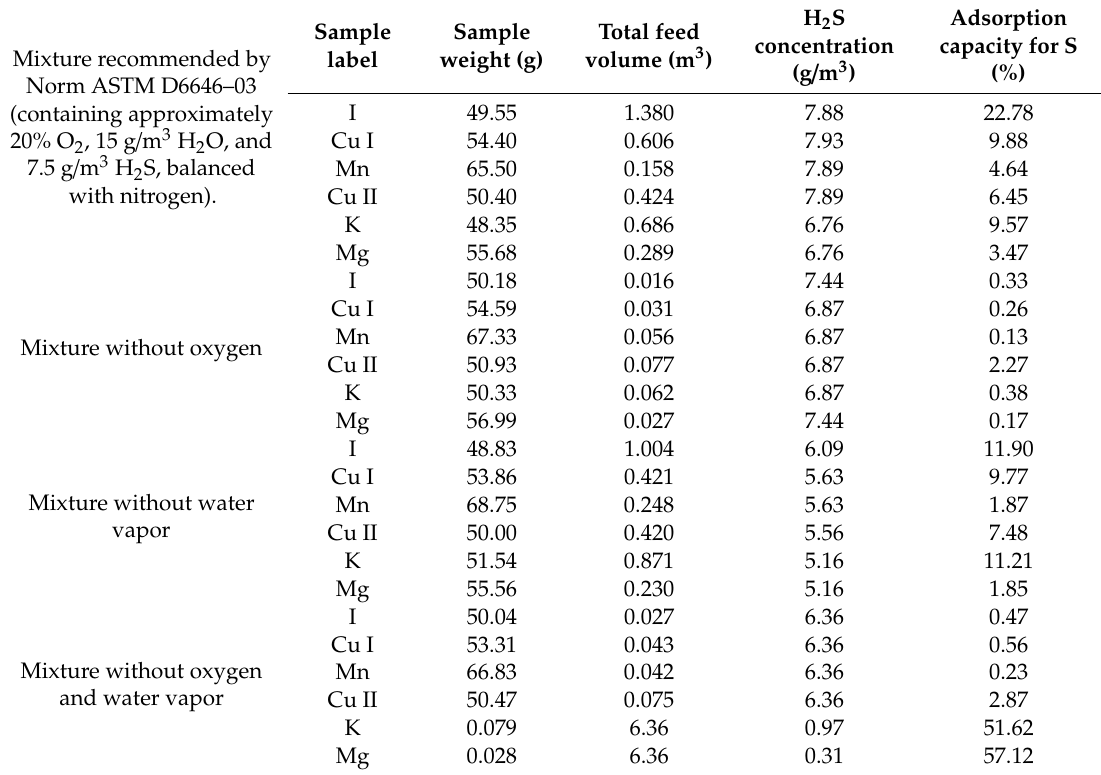
Table 3. Sorbent test results using several gas mixtures (adopted from